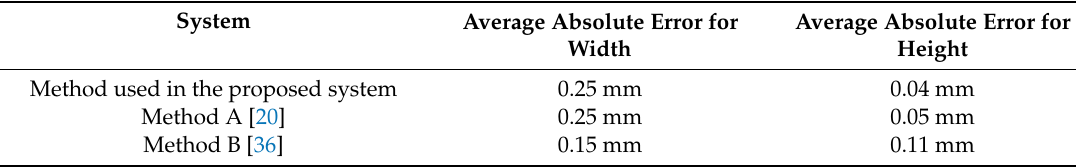
Table 3. Methods comparison.